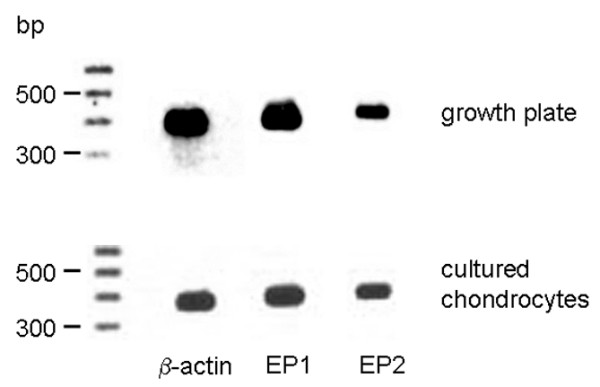
Expression of EP1 and EP2 receptors in rat growth plates and in cultured chondrocytes at the mRNA level. Expression of mRNA for EP1 and EP2 receptors was analysed by reverse transcription RT-PCR. β-actin was used as a positive control. Both growth plate tissue and cultured chondrocytes express mRNA for EP1 and EP2.